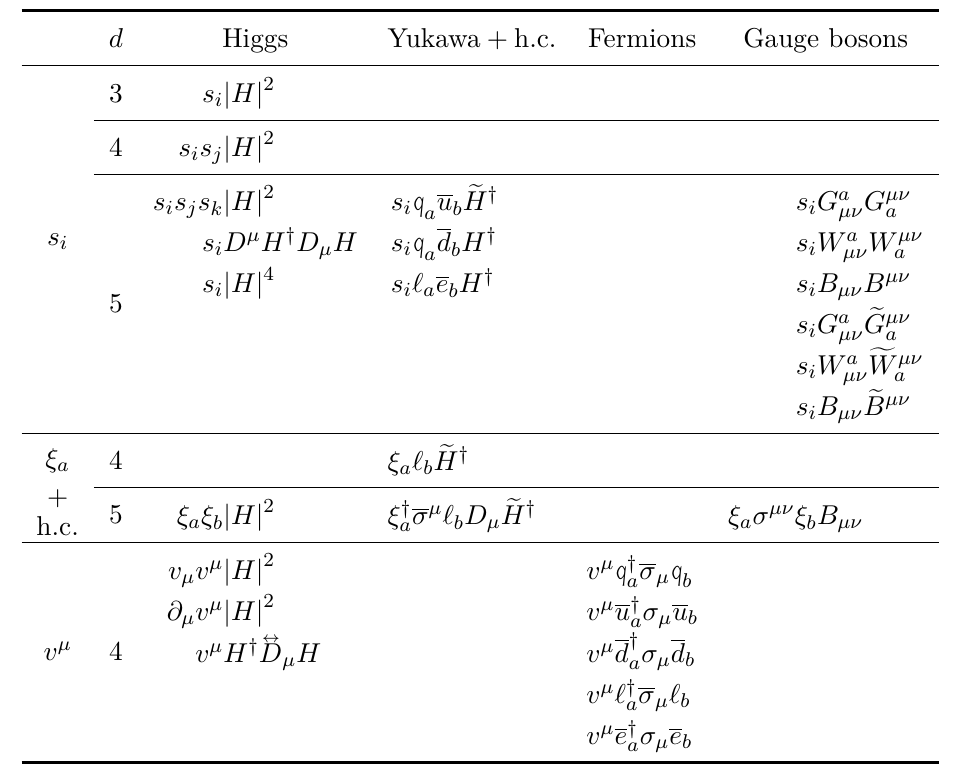
Table 2. List of all operators up to dimension five with SM fields and spin 0 ( s i with i = 1 , 2 ), spin ( ξ with a = 1 , 2 ) or spin 1 ( v µ ) messengers. The first column specifies the spin of the messenger 1 a 2 field, the second column denotes the dimension d of the operator and the remaining columns label the SM sectors the messengers interact with. The left-handed SU(2) doublets ‘ = ( u , d ) T and the right-handed singlets u † q a a a